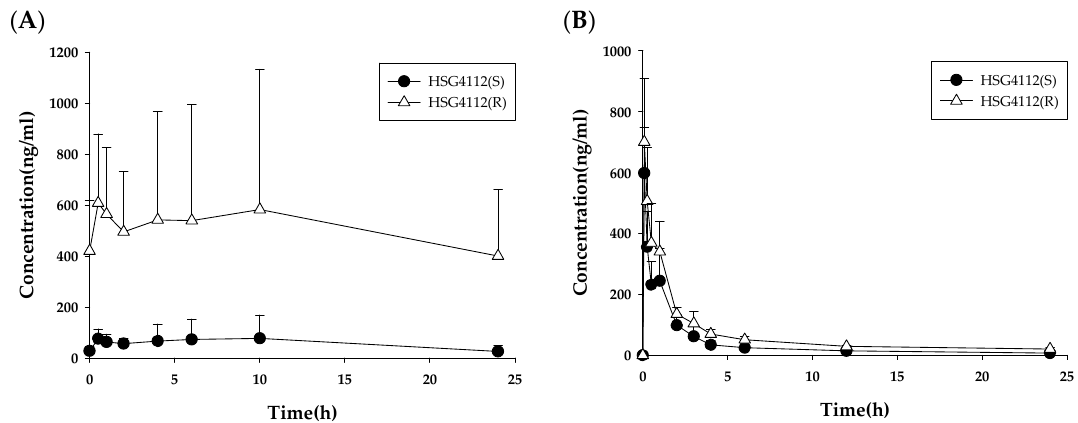
Figure 3. Plot for time–plasma concentration of HSG4112 after ( A ) oral (100 mg / kg / day, 28 th day, n = 3) and ( B ) iv (2 mg / kg, single dose, n = 2) administration in dogs. Table 3. Pharmacokinetic parameters of HSG4112(S) and HSG4112(R) after PO administration at a repeated dose of 100 mg / kg / day to dogs.